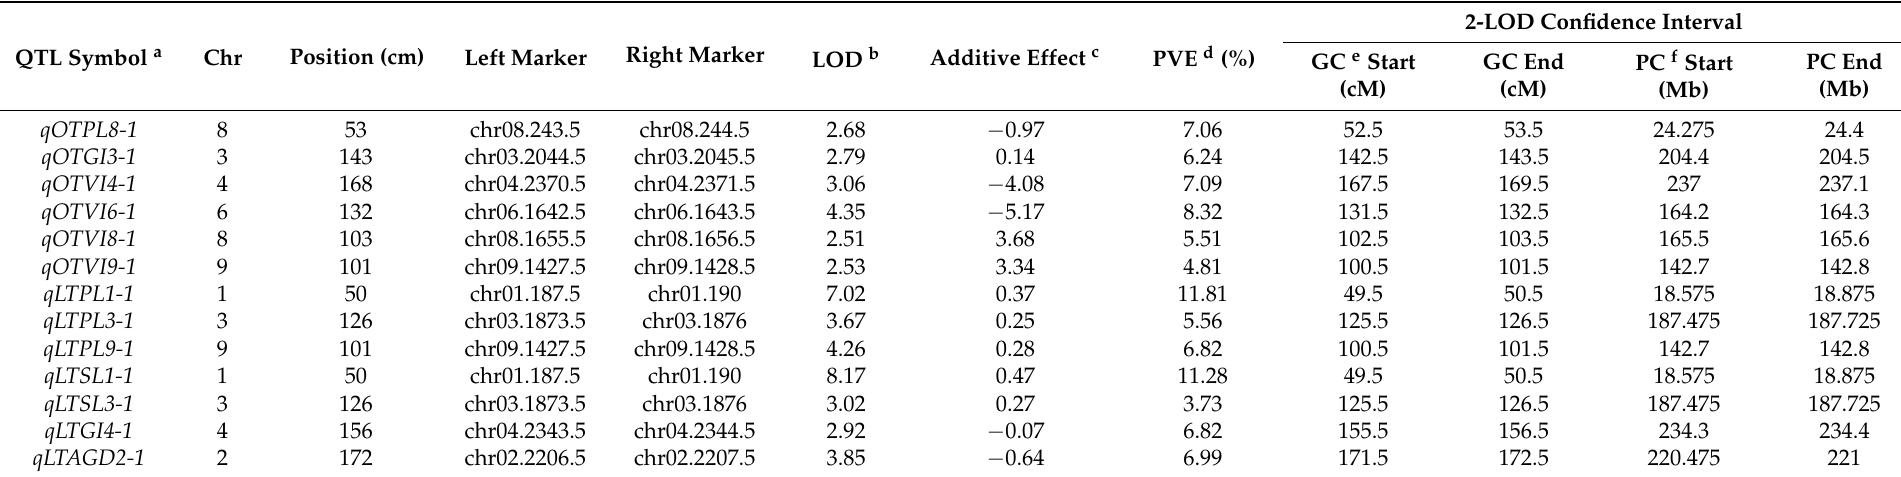
Table 3. Genome-wide QTL identification under optimum and low temperature in IBM Syn10